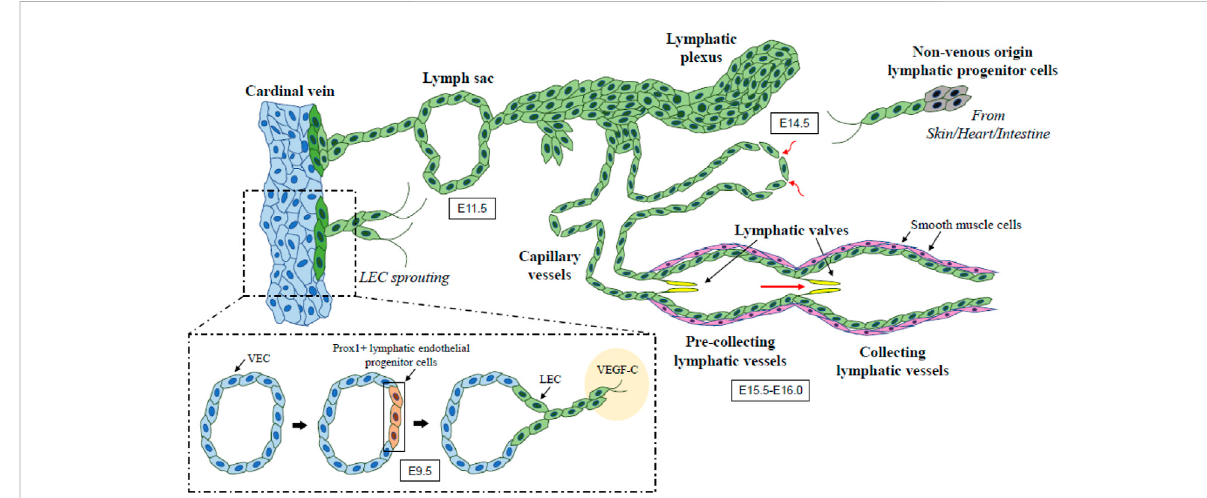
FIGURE 1 Thedevelopmentalprocessoflymphaticvessel .Lymphaticendothelialprogenitorcellsinthecardinalveinbegintoexpress PROX1 (knownas a master lymphatic vascular regulator) at E9.5 and then differentiate into LECs expressing VEGFR3 . VEGF-C/VEGFR3 signaling promotes the sprouting and migration of PROX1 -positive LECs, which leads to the formation of lymph sacs and initial lymphatic plexus by E11.5. Extended sprouting and migration of LECs from the initial lymphatic structures give rise to the hierarchical lymphatic vessel network. Non-venous origin lymphatic endothelial progenitor cells also contribute to the early lymphatic vasculature and the development of its network. This network undergoes remodeling and maturation during E15.5-E16.0 and forms the organized lymphatic vascular network including lymphatic capillaries and pre-collecting and collecting lymphatic vessels. Arrows show the direction of lymph fl ow. LEC, lymphatic endothelial cell; VEC, venous endothelial cell; VEGF, vascular endothelial growth